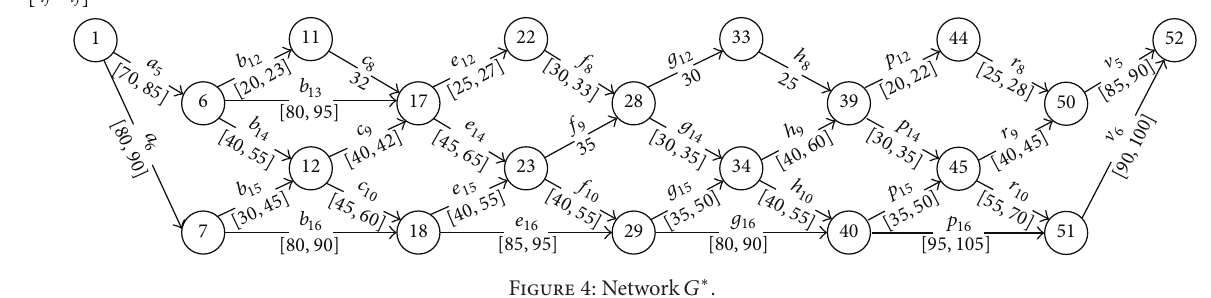
Figure 4: Network 𝐺 ∗